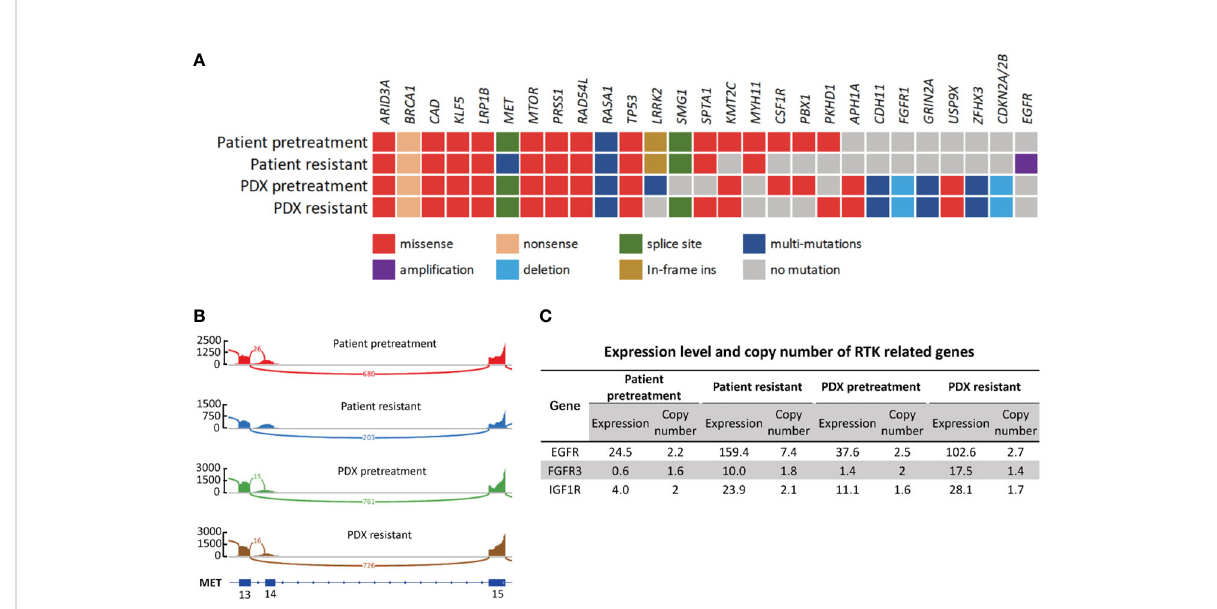
FIGURE 4 Genetic and transcriptomic characterization of tumors from the patient and the corresponding PDX models. (A) Co-mutation plot of genomic alterations across tumor specimens from patient and PDX models. Mutations and frequency of each gene are listed in Supplementary Table S1. (B) Sashimi plot of MET exon14 skipping event in patient and PDX tumor specimens. The Y axis indicates read density, the number on arc represents junction reads, and portion of schematic MET transcripts with exon number is the plot at the bottom. The fi gure was adapted from IGV (19). (C) Expression level and copy number of RTK related genes in patient and PDX model tumor specimens. Numbers are presented in